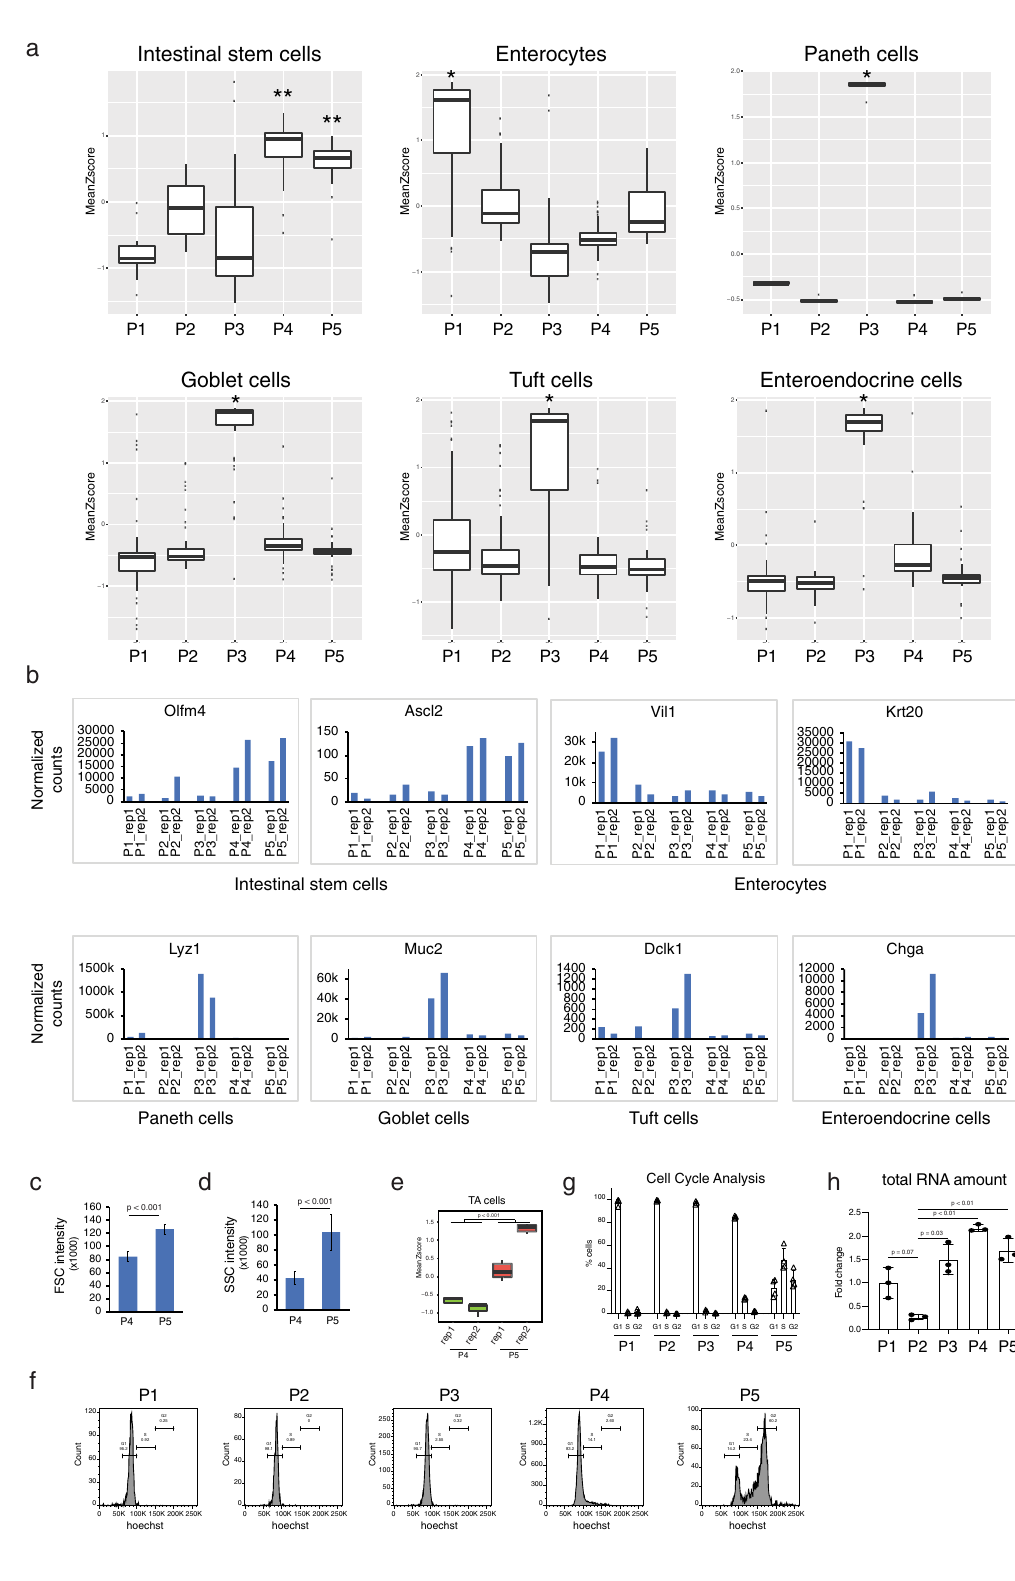
incubated with Ki67 antibody in blocking buffer for 1h at RT. Of note, endogenous OSCAR fl uorescence is very sensitive to fi xation, thus for other organs should